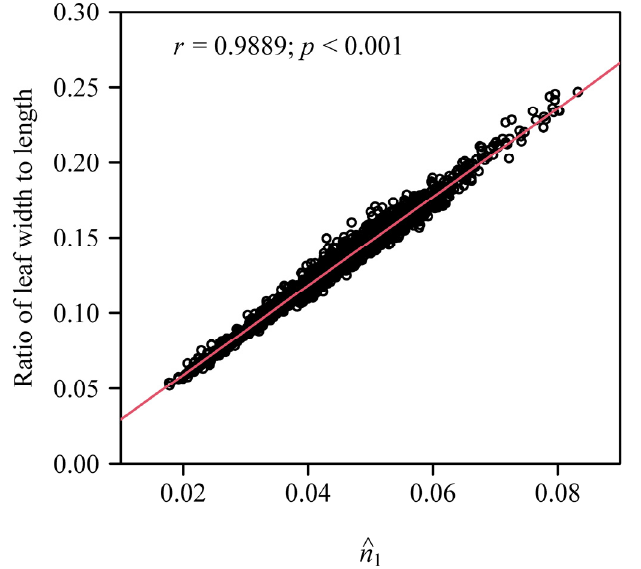
Figure 6. The correlation between the estimated values of the model parameter n 1 for SGE-1 and the ratios of leaf width to length.